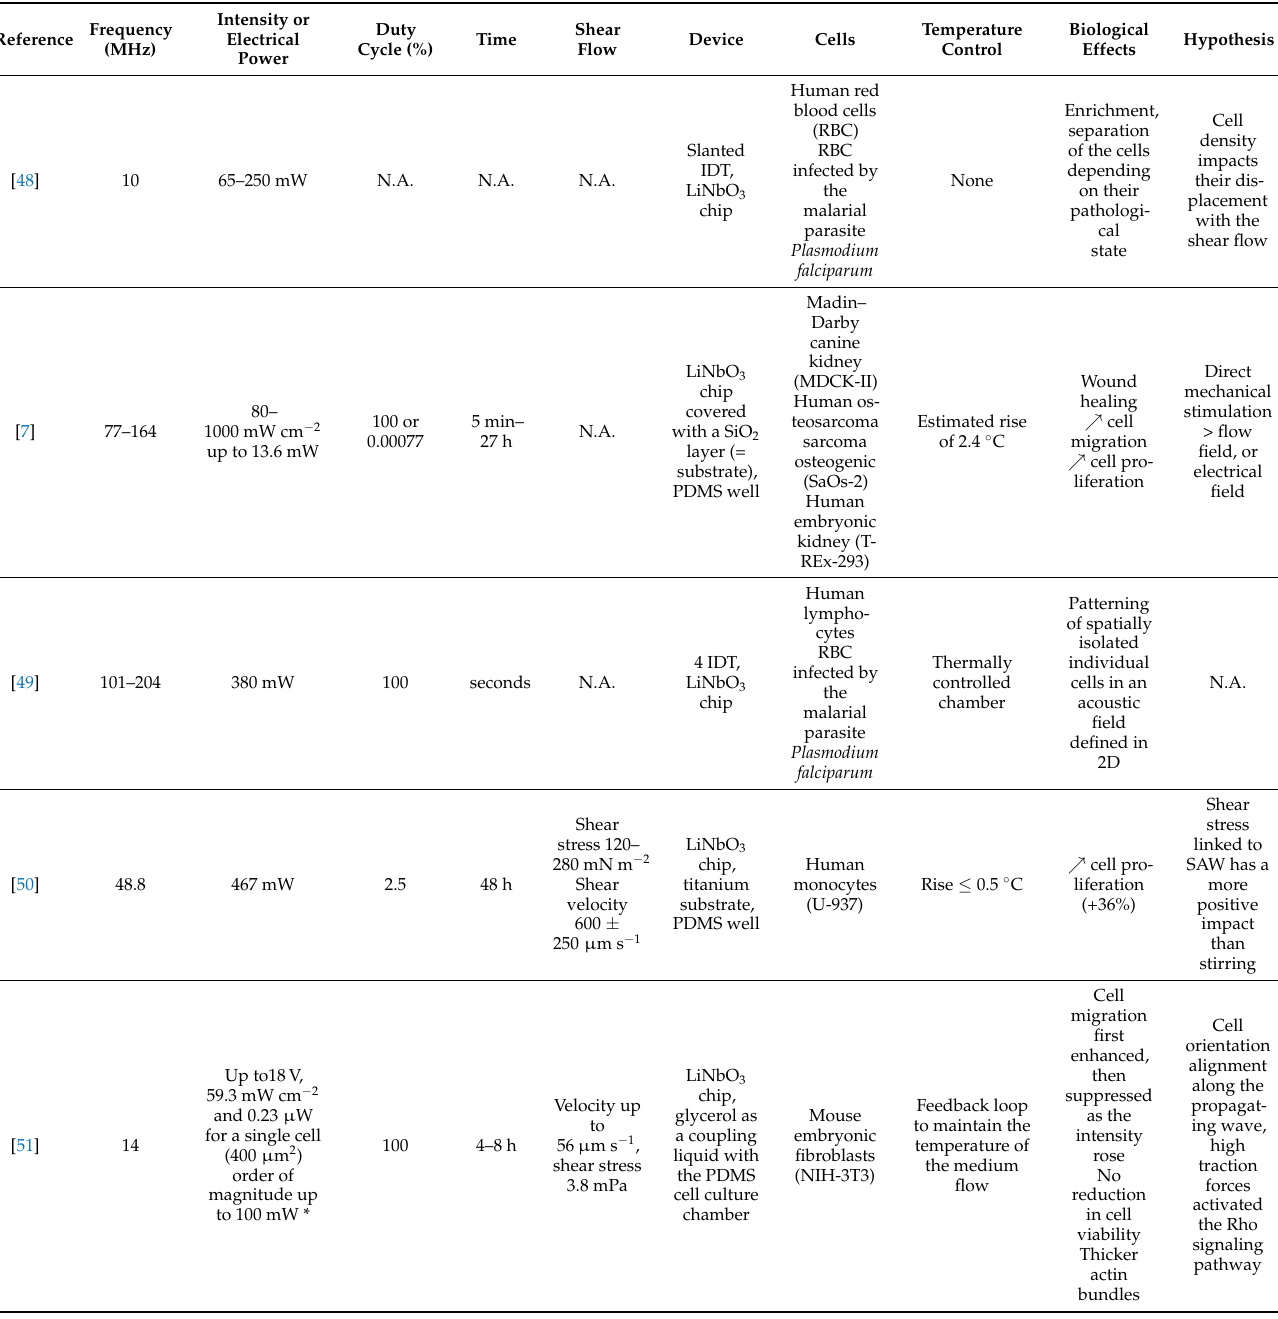
Table 3. Summary table of the impacts on mammal cells of SAW. ( (cid:37) : increase in, (cid:38) : decrease in, N.A.: not available, AFM: atomic force microscopy, IDT: interdigital transistor, PDMS: polydimethylsiloxane, *: extrapolation based on the hypothesis that the electrode impedance is at 50 Ω